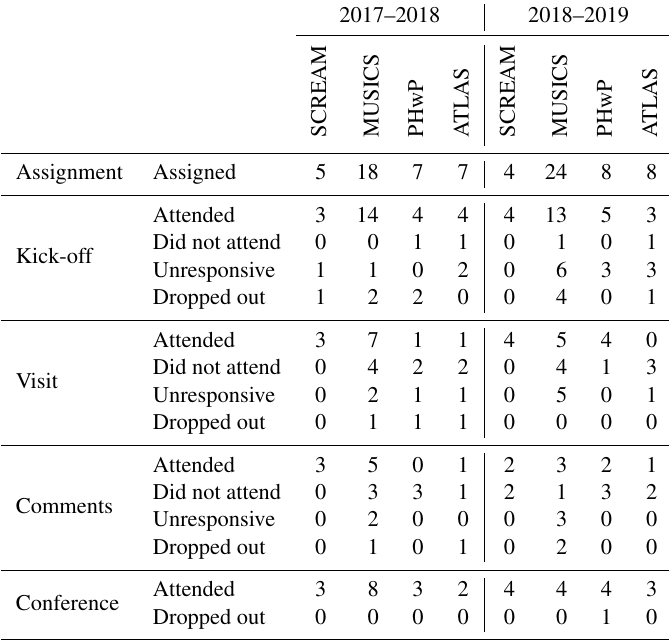
Table D1. Data on the retention of schools within PRiSE across intervention